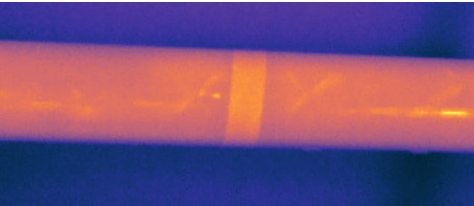
Figure 2. Infrared image of the experiment to measure emissivity using an electrical tape stuck on the surface. The result of the emissivity measurement procedure indicates that the global emissivity of the surface of the bicycle frame perpendicular to the camera is